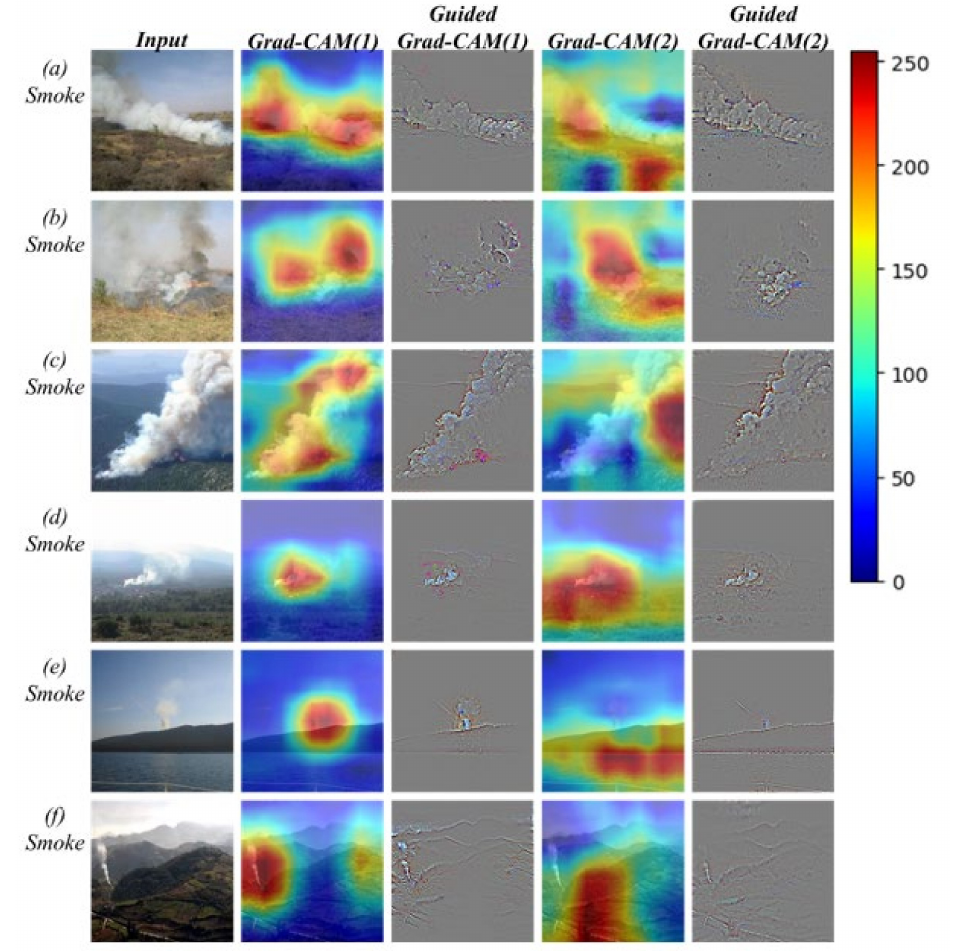
Figure 6. Grad-CAM and guided Grad-CAM visualization of randomly selected ( a – f ) smoke